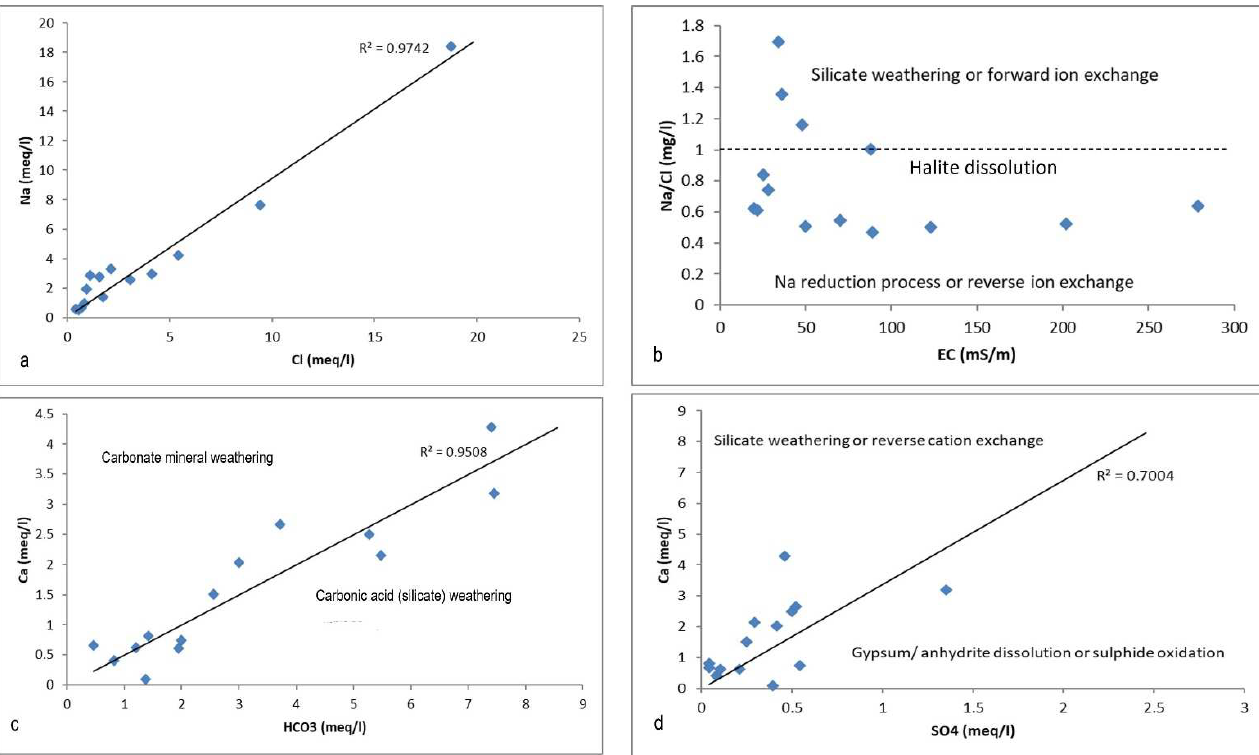
Figure 6. Scatter plots for ( a ) Ca 2+ + Mg 2+ /Na + and ( b ) Ca 2+ + Mg 2+ /HCO 3− + SO 4− of water collected in the Soutpansberg region.